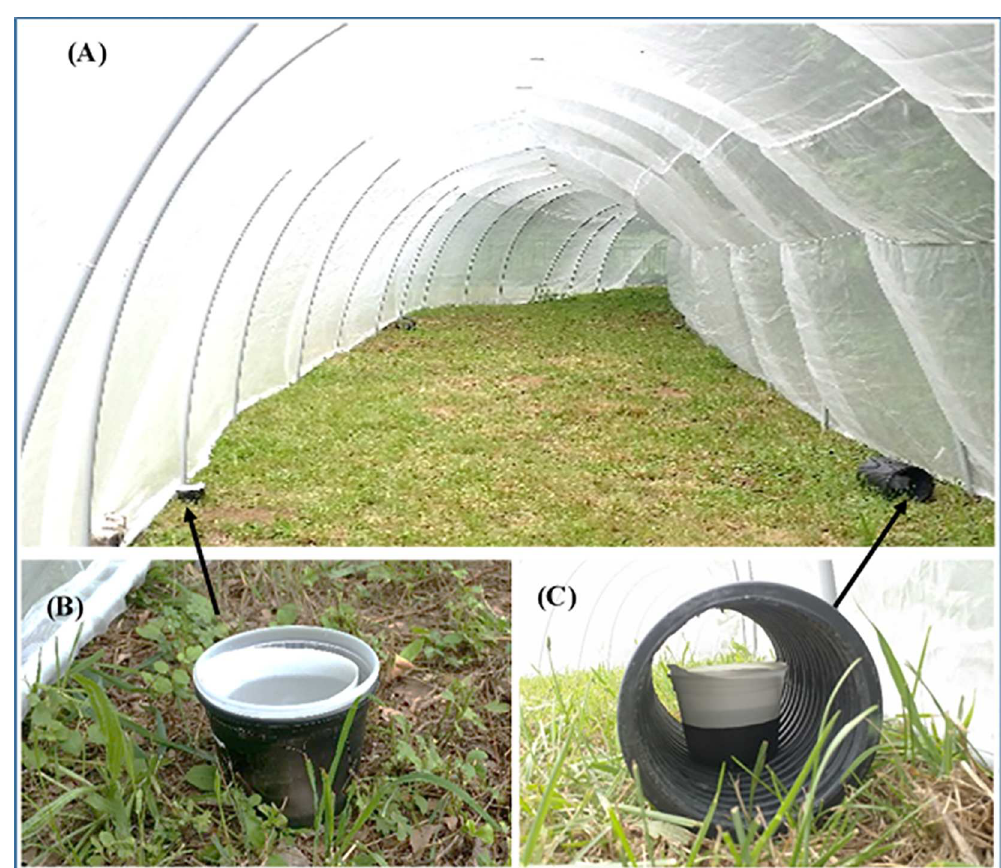
Fig 1. Large field cage (A) for assessingthe ovipositionpreference of Ae . albopictus females in open (B) vs . cryptic (C)